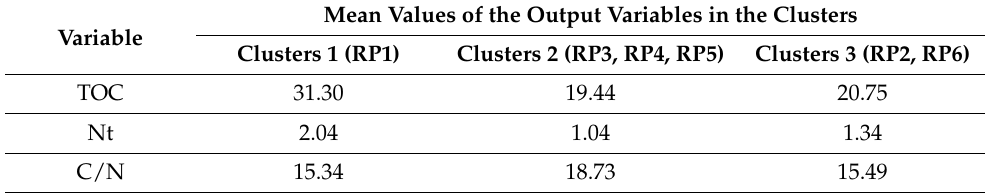
Table 6. Mean values of the output variables in individual clusters for TOC, Nt and C/N. Mean Values of the Output Variables in the Clusters Variable Clusters 1